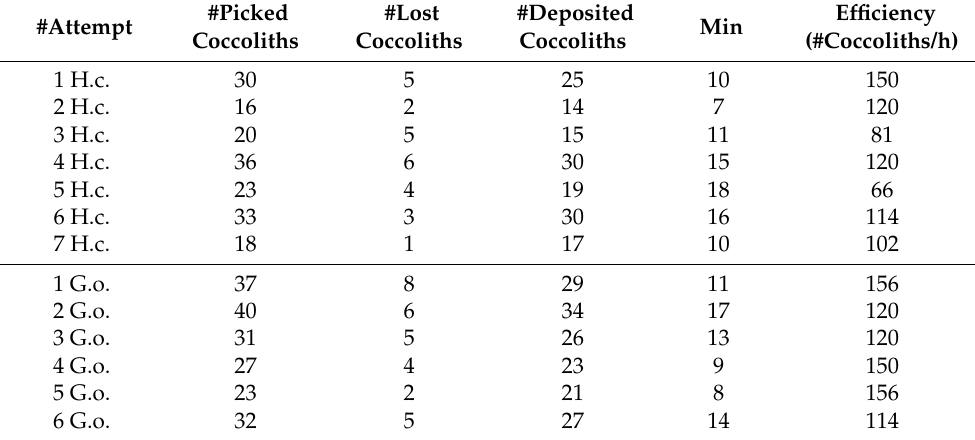
Table 1. Data collected to evaluate the efficiency of the hydraulic micromanipulation system in picking monospecific nannofossils of H. carteri (H.c.) and G. oceanica (G.o.). Reported in the table are: the number of attempts of a complete capture–release procedure; the number of picked coccoliths during the capture phase; the ones lost in the process of moving the capillary out from the suspension before deposition; the ones deposited on the selected sample holder; the time necessary for the entire procedure (min); the efficiency of the methodology expressed as number of coccoliths deposited versus time (h). Hashtag (#) means